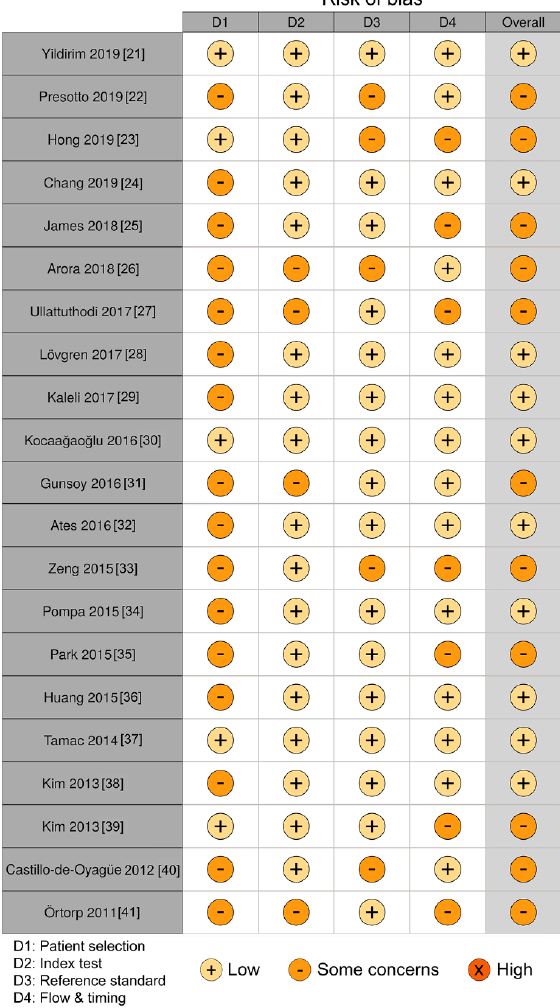
Figure 2. Quality assessment results according to the Quality Assessment Tool for Diagnostic Accuracy Studies-2 (QUADAS-2).